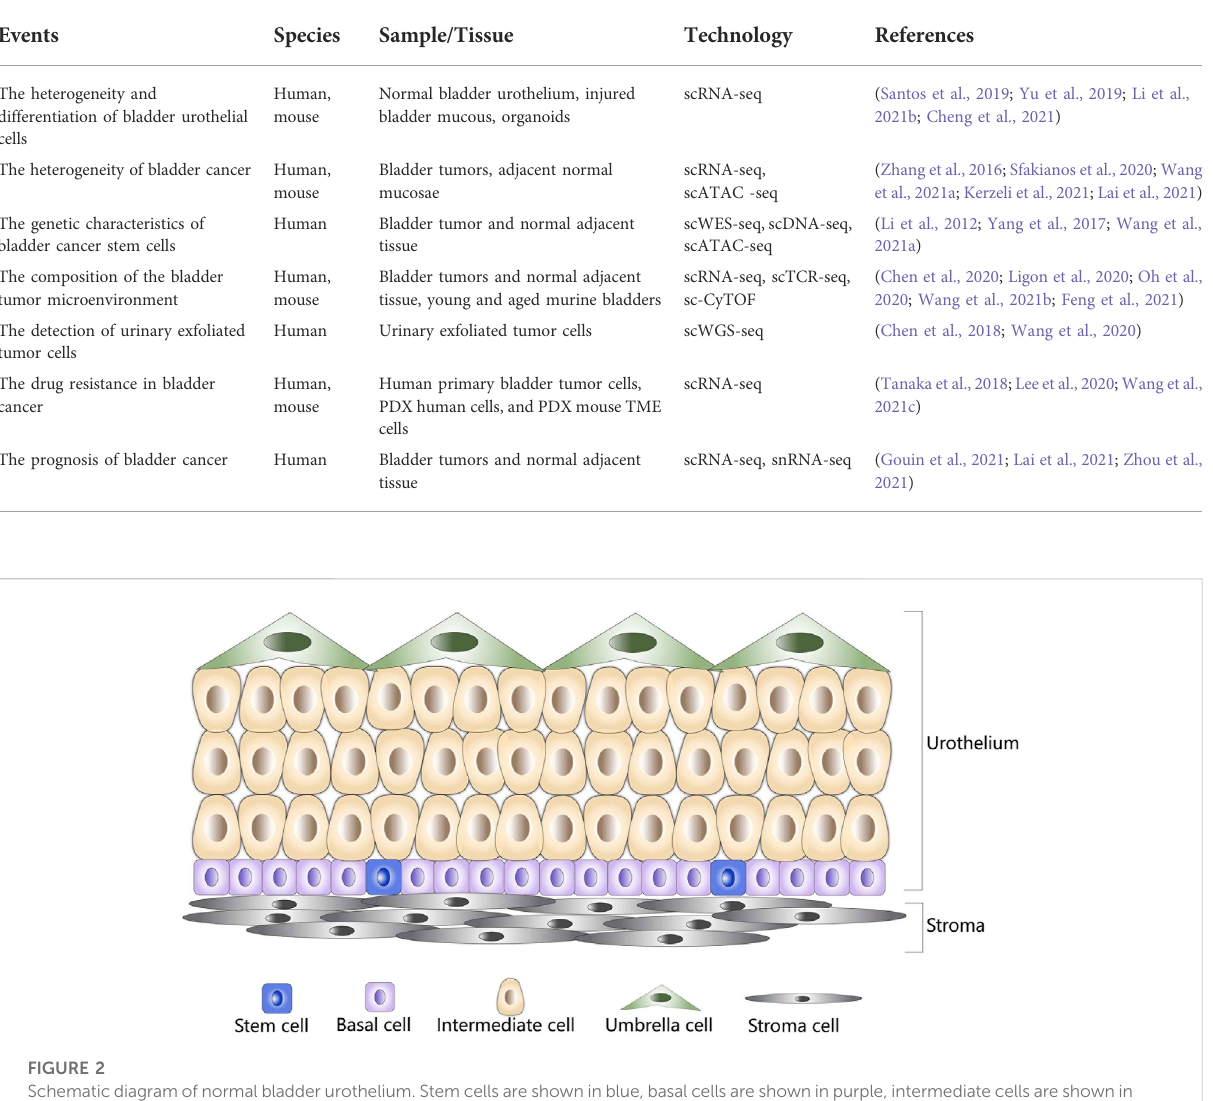
TABLE 2 Summary of the studies in bladder cancer using single-cell technologies.